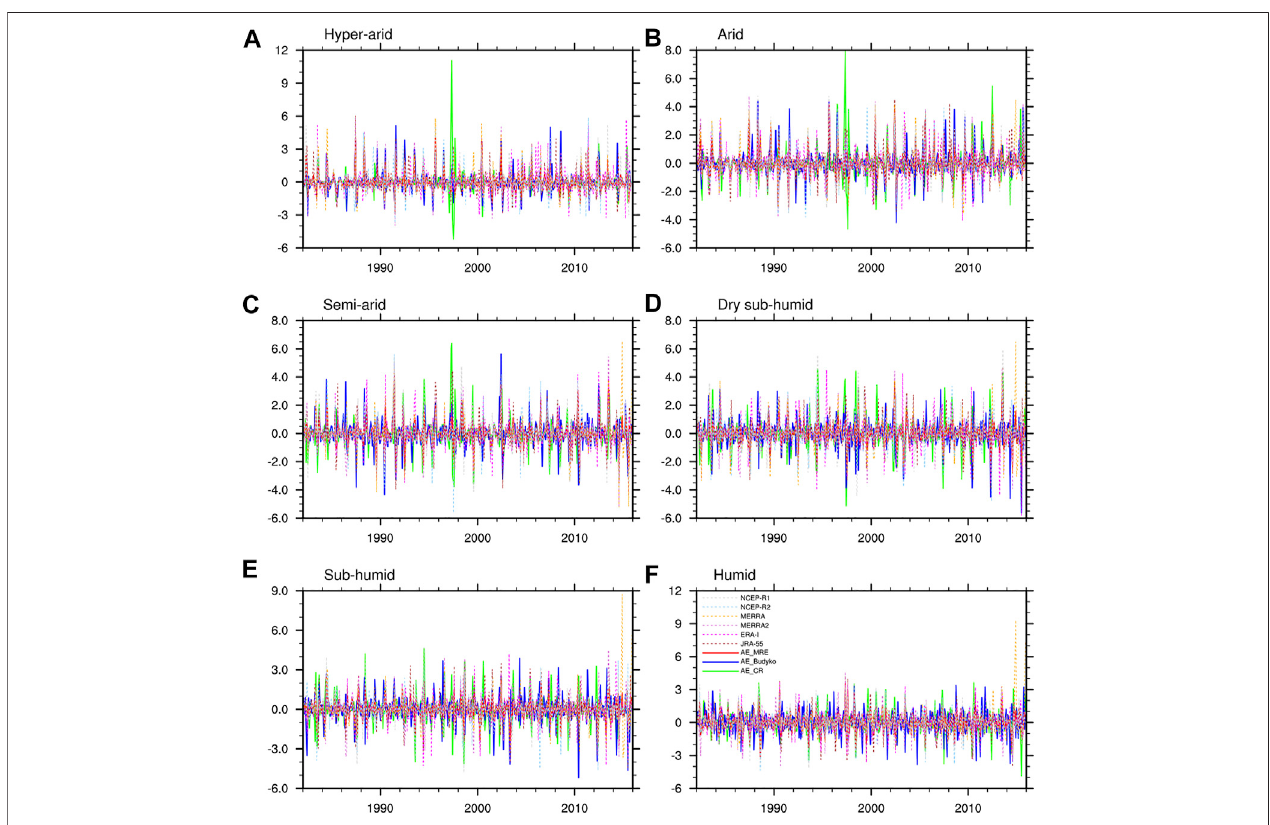
FIGURE6| X-12-ARIMAirregularcomponents( I t )ofactualevapotranspiration(AE)derivedfromAE_WAR,AE_CR,AE_Budyko,andreanalysesoverthe (A) hyper- arid, (B) arid, (C) semi-arid, (D) dry sub-humid, (E) sub-humid, and (F) humid regions.